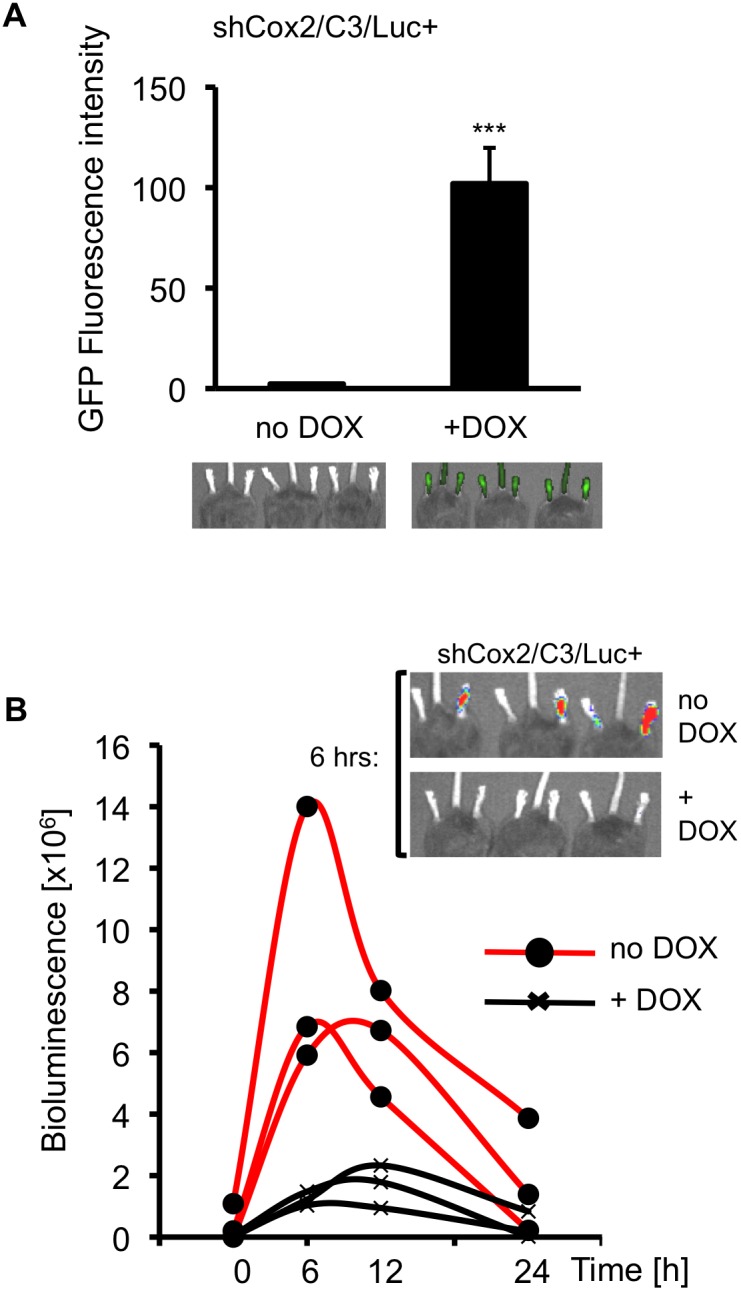
DOX-dependent suppression of Cox2 driven luciferase expression in triple transgenic mice during zymosan-induced paw inflammation.(A) Fluorescent in vivo GFP imaging of shCox2/C3/Luc+ triple transgenic mice fed either a control diet (no DOX) or a DOX-containing diet (+DOX) for 12 days. GFP fluorescence was quantified with Living Image software. Data are means +/− SD, (n  = 3; ***, p<0.001). (B) ShCox2/C3/Luc+ mice were injected intraplantarly in the left hind paw with zymosan (30 µL, 2% w/v) and with saline in the contralateral hind paw. In vivo luciferase bioluminescence was non-invasively and repeatedly measured and quantified at the indicated time points. Each curve represents data from an individual animal. To control for individual animal variability the bioluminescence in the contralateral control saline-infected paw was subtracted from the bioluminescence value of the zymosan-injected paw for each observation.